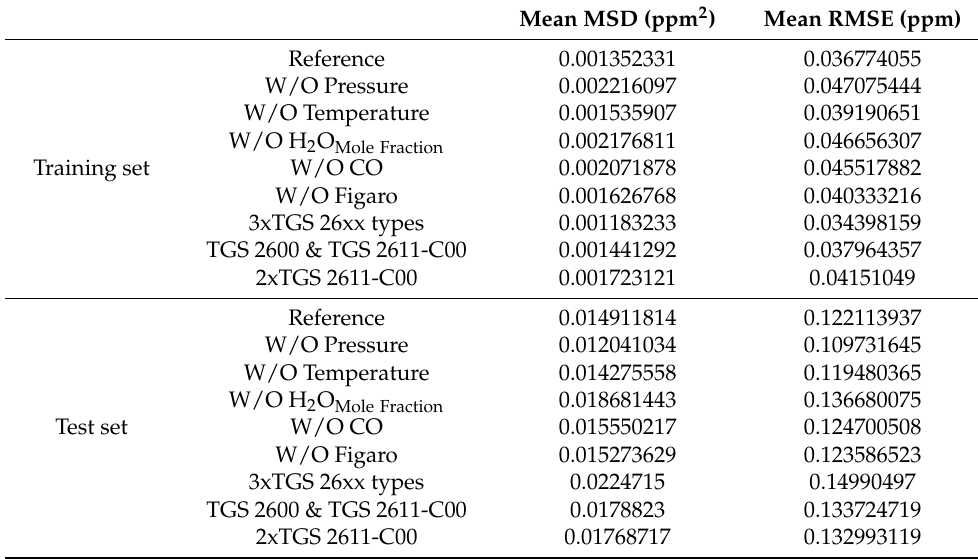
Table A1. Mean MSD and RMSE for the 50 training and test periods of the sensitivity